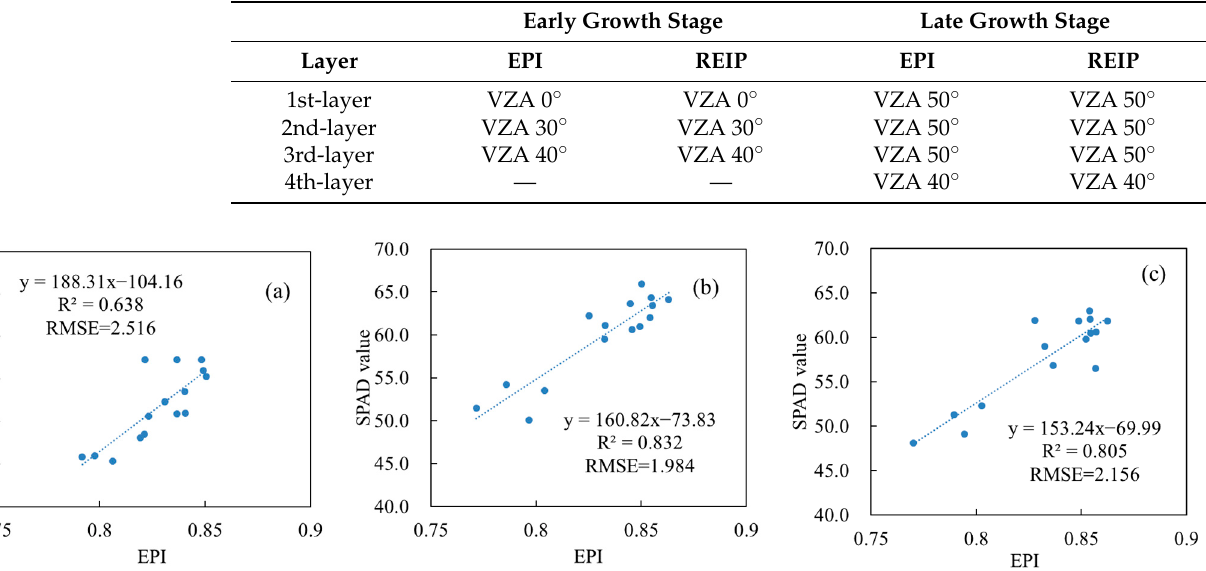
Figure 6. Relationship between SPAD values at different layers and the EPI under the optimum VZA in the early growth stage: ( a ) 1st layer, ( b ) 2nd layer, and ( c ) 3rd layer.